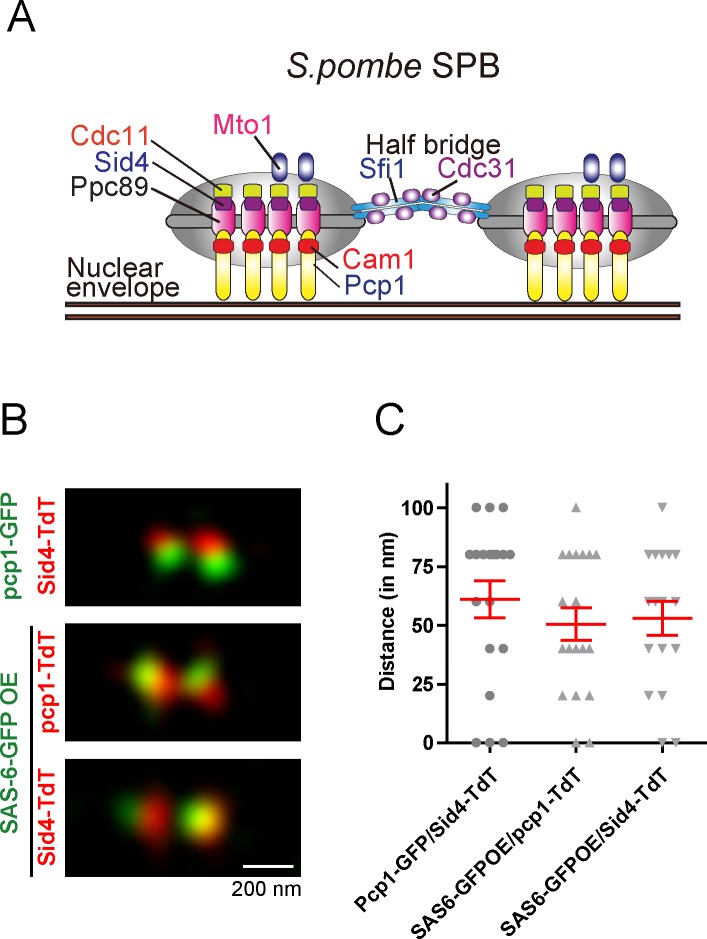
SAS-6-GFP localization within the fission yeast SPB revealed by structured illumination microscopy (SIM).(A) Schematic representation of localization of components in the duplicated interphase fission yeast SPBs. The illustrated SPB structure was adapted and modified from Ito and Bettencourt-Dias (2018). (B) Representative SIM images of localization of GFP or tdTomato-tagged Pcp1, Sid4 and SAS-6 at the duplicated SPBs. Scale bar, 200 nm. (B) Interfoci distances between the indicated SPB-bound proteins measured by SIM images.10.7554/eLife.41418.011Figure 4—figure supplement 1—source data 1.The source data to plot the graph in Figure 4—figure supplement 1C.